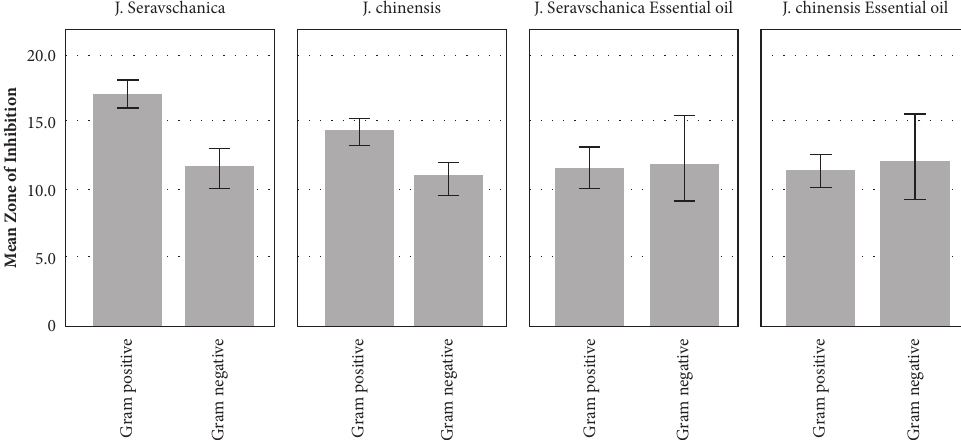
Figure 1: Comparison of antibacterial capacity of the methanolic extracts (100 μ g) of J. seravschanica and J. chinensis and essential oil of J. seravschanica and J. chinensis against Gram-positive and Gram-negative bacteria. The p value of the independent sample t -test for the methanolic extract of J. seravschanica and J. chinensis was < 0.001 and for J. seravschanica and J. chinensis essential oil was >